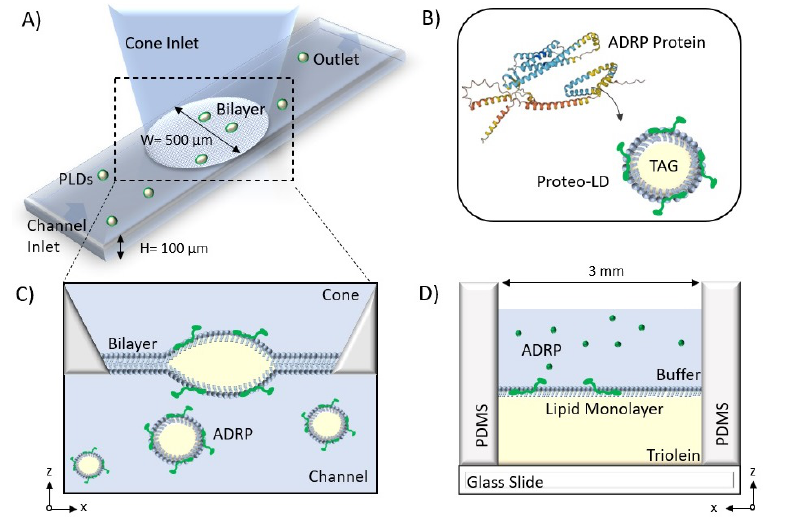
Figure 1. ( A ) Schematic of the microfluidic system to form a free-standing bilayer containing Proteo- LDs. ( B ) The secondary structure of ADRP was provided by the AlphaFold AI database. ADRP is reconstituted in the PC:PE monolayer covering the LD. ( C ) A bilayer is formed at the aperture between the channel and the cone, and LDs containing ADRP protein are introduced from the bottom channel and insert into the bilayer. ( D ) Schematic of the microfluidic device to form the free-standing monolayer. A phospholipid monolayer is formed at the buffer–triolein